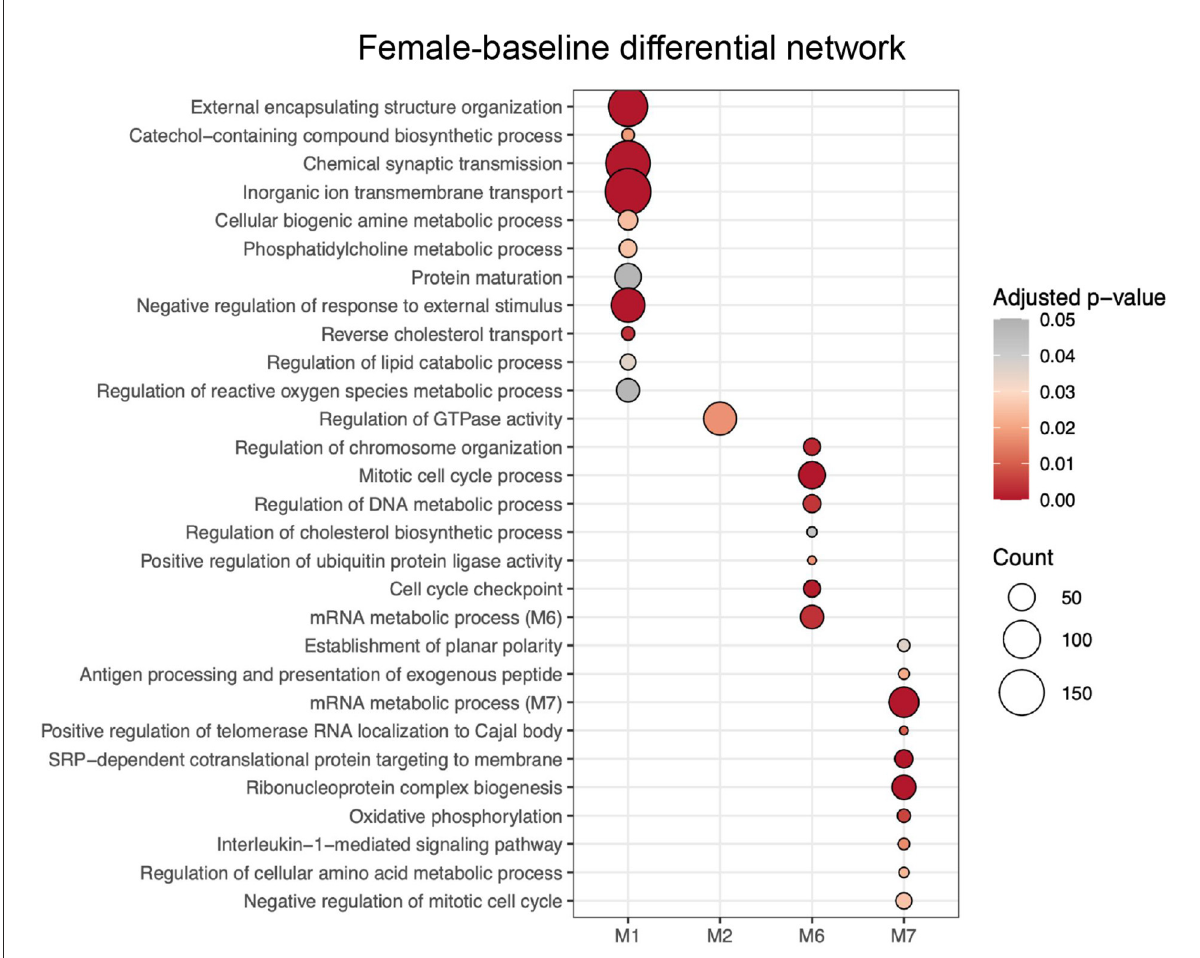
FIGURE3 GO terms enrichment of modules from female-baseline differential network resulted from ALPACA analysis of differences in network topology from PANDA networks. GO terms were chosen according to their uniqueness, dispensability and significance based on REVIGO analysis. The color of the circle indicates the over-representation adjusted p -value, and the size represents the number of genes corresponding to the GO